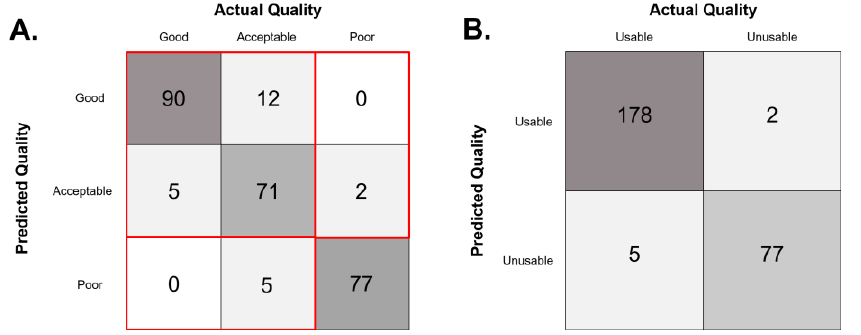
Figure 2. ( A ) Raw count confusion matrix for the three-class model tested on 262 glaucoma-specialist graded disc photographs. Areas outlined in red show the regions collapsed to generate the binary outcome confusion matrix represented in ( B ).